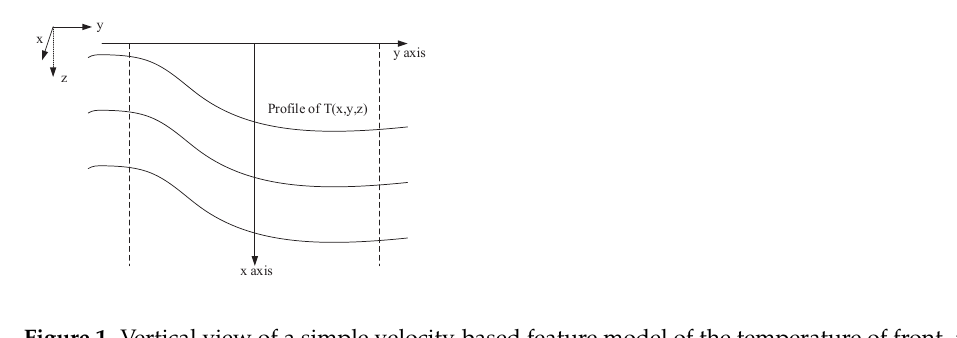
Figure 1. Vertical view of a simple velocity-based feature model of the temperature of front, x the dimensional along-front coordinate, y the cross-front coordinate with origin at the centre of the front and z the dimensional vertical coordinate (positive